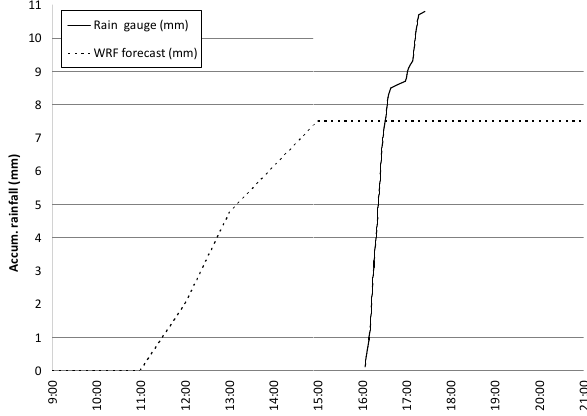
Fig. 8. Rainfall forecast by WRF for the January 2010 flash flood. The cumulative rainfall at the end of the rain event (23h on 18 Jan- uary 2010) is shown.